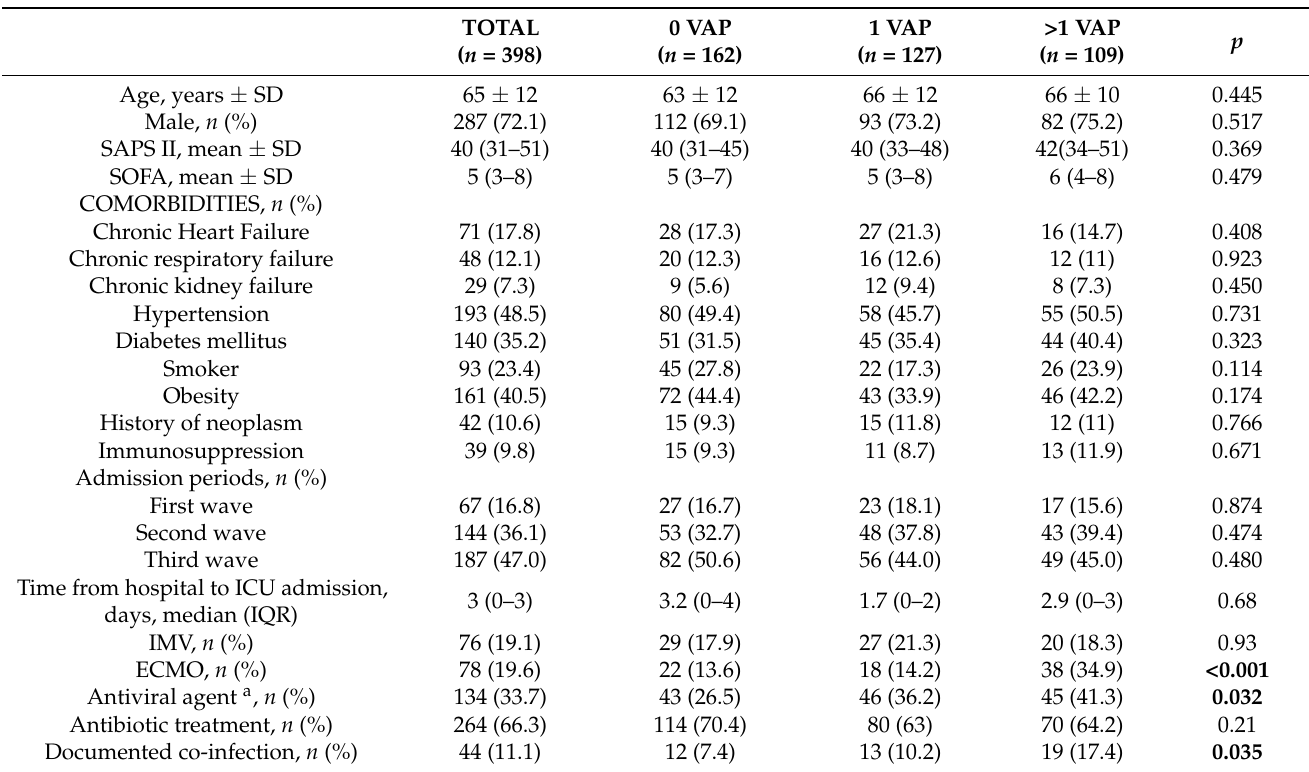
Table 1. Patients’ main characteristics at ICU admission according to the occurrence of VAP.